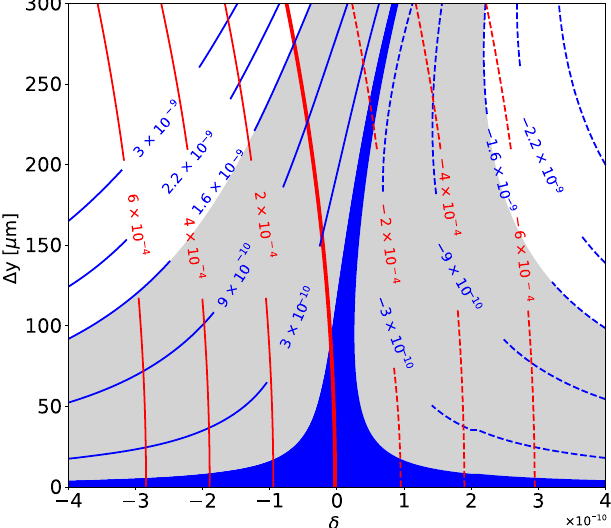
FIG. 9. Contour plot of the radial and vertical linear spin buildup (in units of [rad/s]) as a function of the initial momentum offset δ and the vertical misalignment of one quadrupole in the ring. The numbers along with the red and blue lines are the radial and vertical spin buildup, respectively. The gray area defines the boundary of the aimed EDM sensitivity of (cid:3) 1 . 6